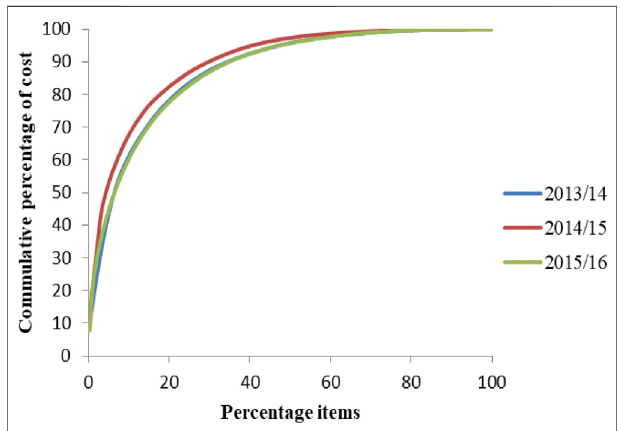
FIGURE 1 | ABC analysis curve of medicines in SPHMMC (2013/ 14 – 2015/16), March 2017.